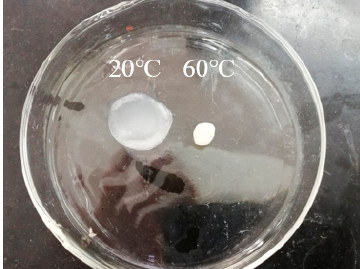
Figure 2. Photographs of the interpenetrating network (IPN) hydrogel after infusion in deionized water at 20 and 60 °C.